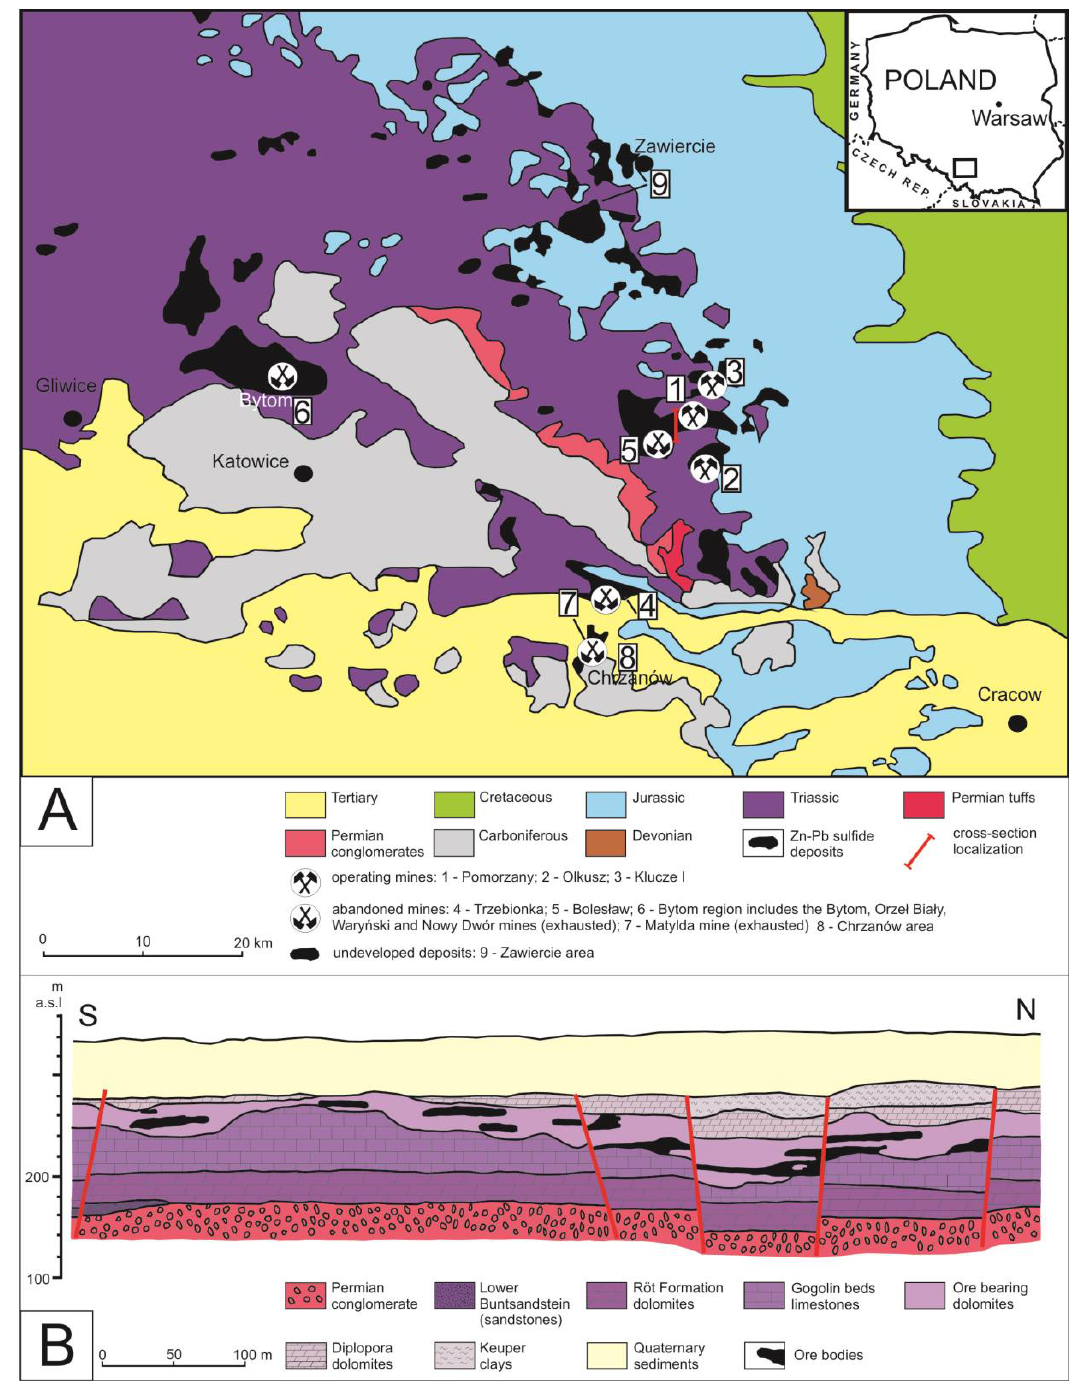
Figure 3. ( A ) Location of the Zn-Pb active and abandoned mines and undeveloped deposits on the schematic geological background (without Quaternary sediments) in the Silesia-Cracow Zn-Pb district, modified after [3] and ( B ) cross-section through the Zn-Pb ore deposit of the Pomorzany mine modified after [22].